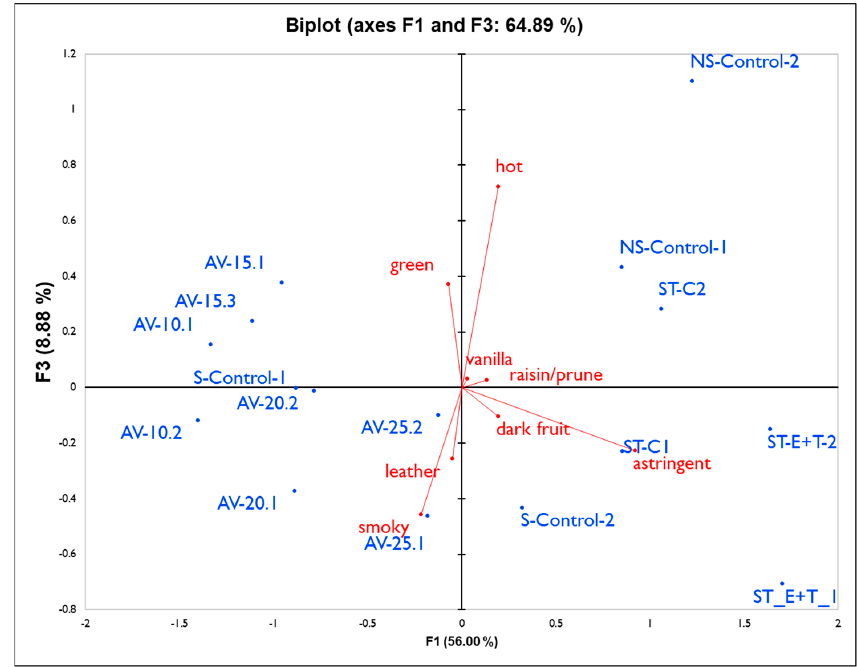
Figure 4. PCA biplot with the first and third PC for all wine treatments from panel 2.